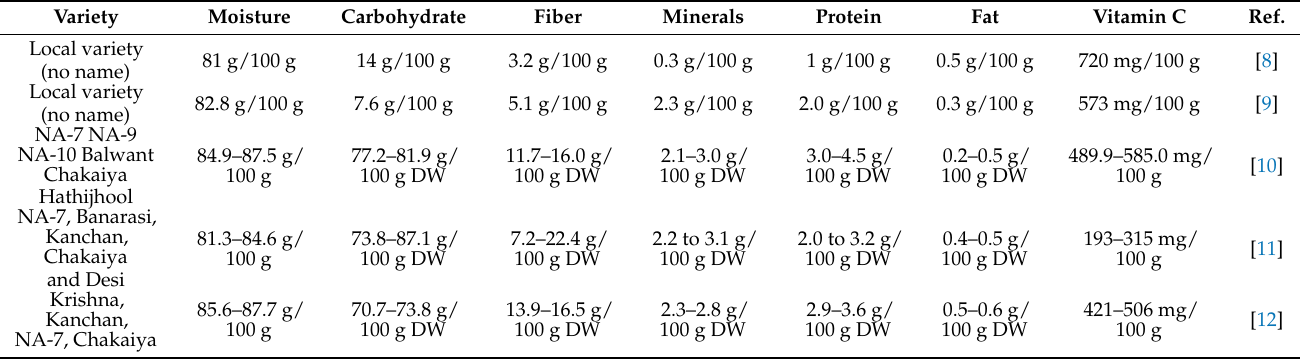
Table 1. Nutritional constituents of amla fruit from different